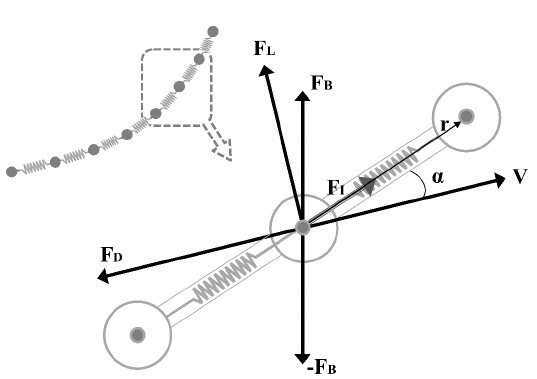
Figure 2. Details of the mass-spring model and factors acting on one mass-spring.